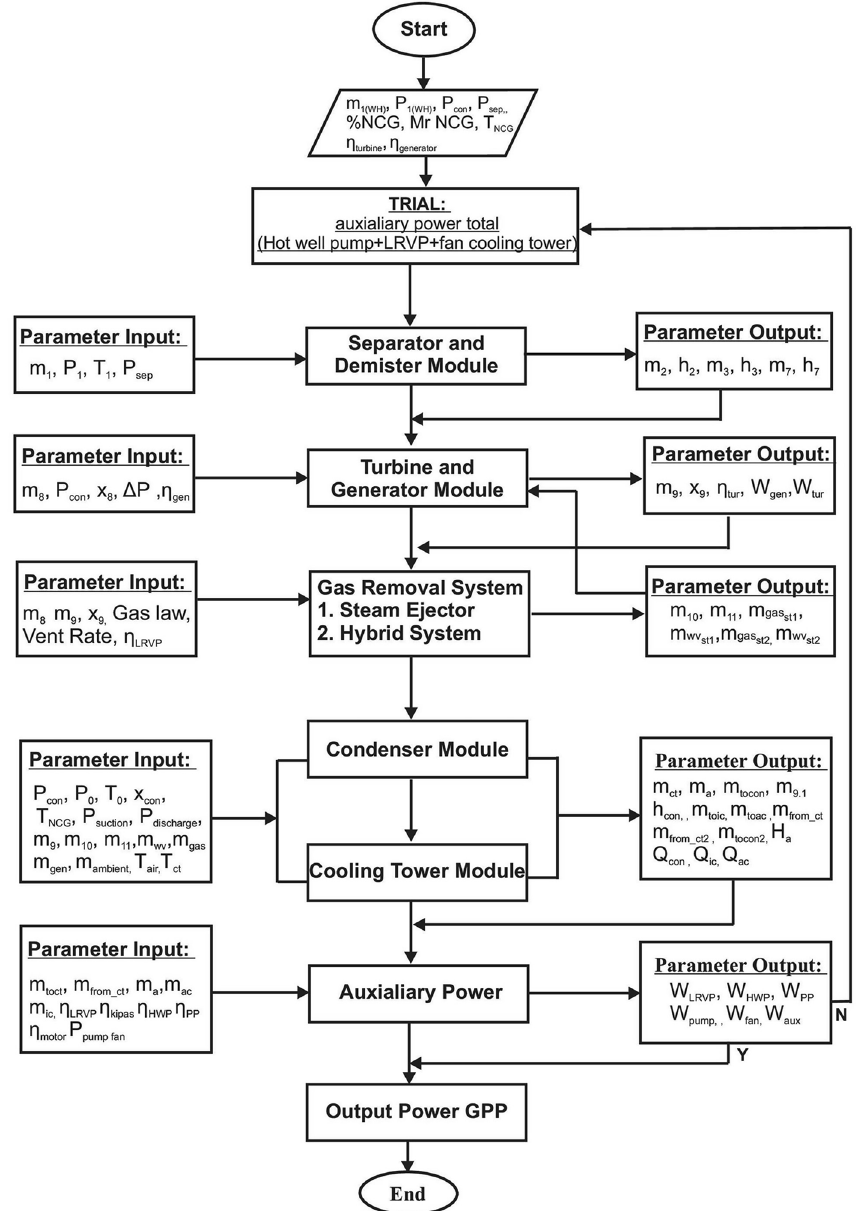
Fig. 12 Flowchart of the thermodynamical model of a single-flash